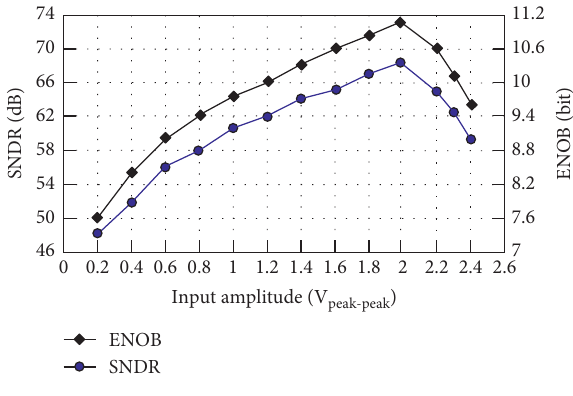
Figure 10: Output SNDR vs. input amplitude.